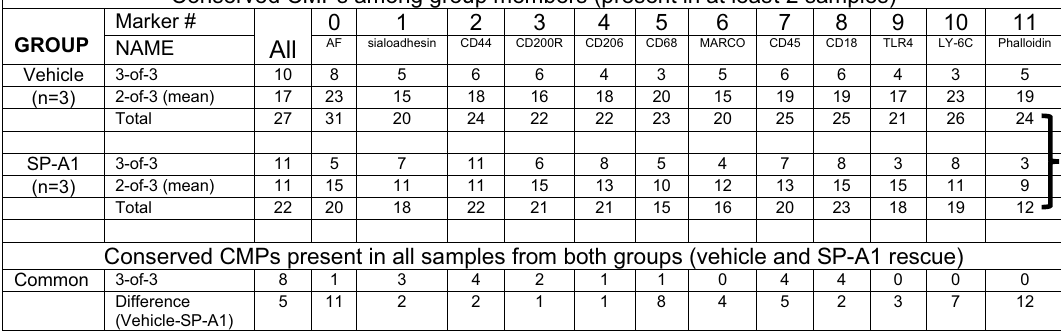
Single cell analysis. From each whole image, a number of single cells were selected, mapped, and the pixels making up that cell defined. This allowed us to compare CMPs in individual single cells. A representative image from one of the samples in this study is shown in Fig. 3. A total of 103 cells were selected from the 6 samples studied. This total consisted of 48 cells from the SP-A1 rescue group (n = 3 rescue mice) and 55 cells from the Vehicle group (n = 3 vehicle mice). The CMPs from each of these cells were used for cluster analysis. Hierarchical cluster analysis. First, we applied the 12-marker data set to a clustering analysis. Figure 4 is a clus- ter dendrogram compiled from the 103 cells from the female data set. As mentioned above, these included the CMP data from 48 cells for the SP-A1 rescue group and 55 cells from the Vehicle group. Each group contained cells obtained from three mice. The cluster analysis defined 7 clusters, each of whose composition of vehicle and rescue cells is shown in Table 3. As in the cluster analysis of other datasets that we have reported, the data from